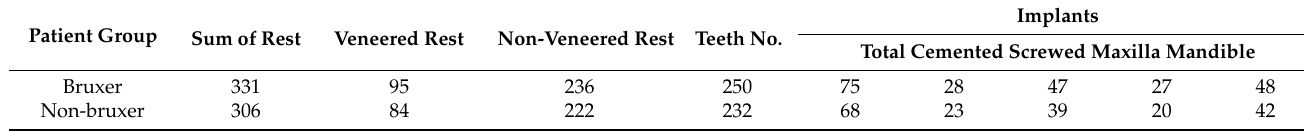
Table 1. Number of restorations and abutments in both